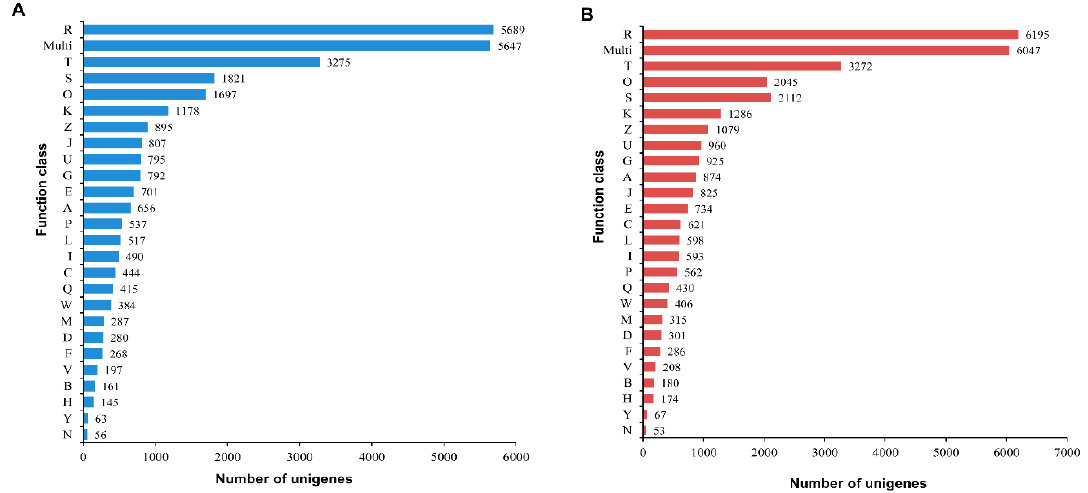
Figure 7. COG classification of ( A ) A. chejuensis and ( B ) A. quelpartensis unigenes. The code